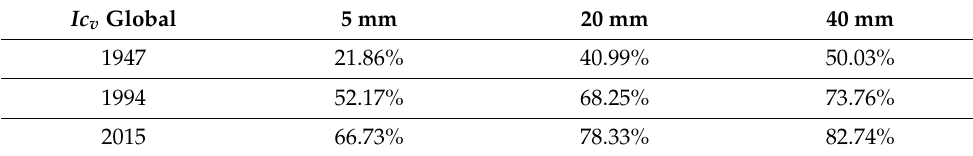
Table 2. Evolution of the connectivity indicator Ic v